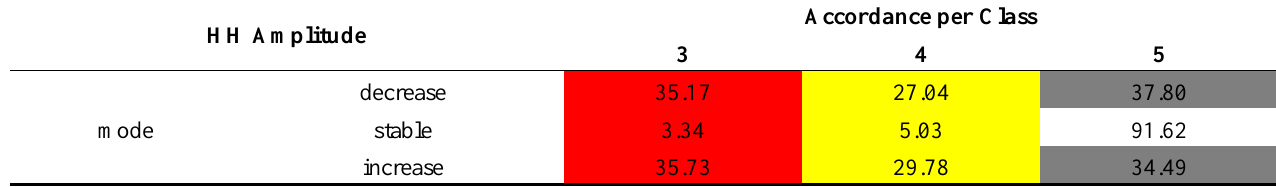
Table 1. Concordance per class in (%) of the five human